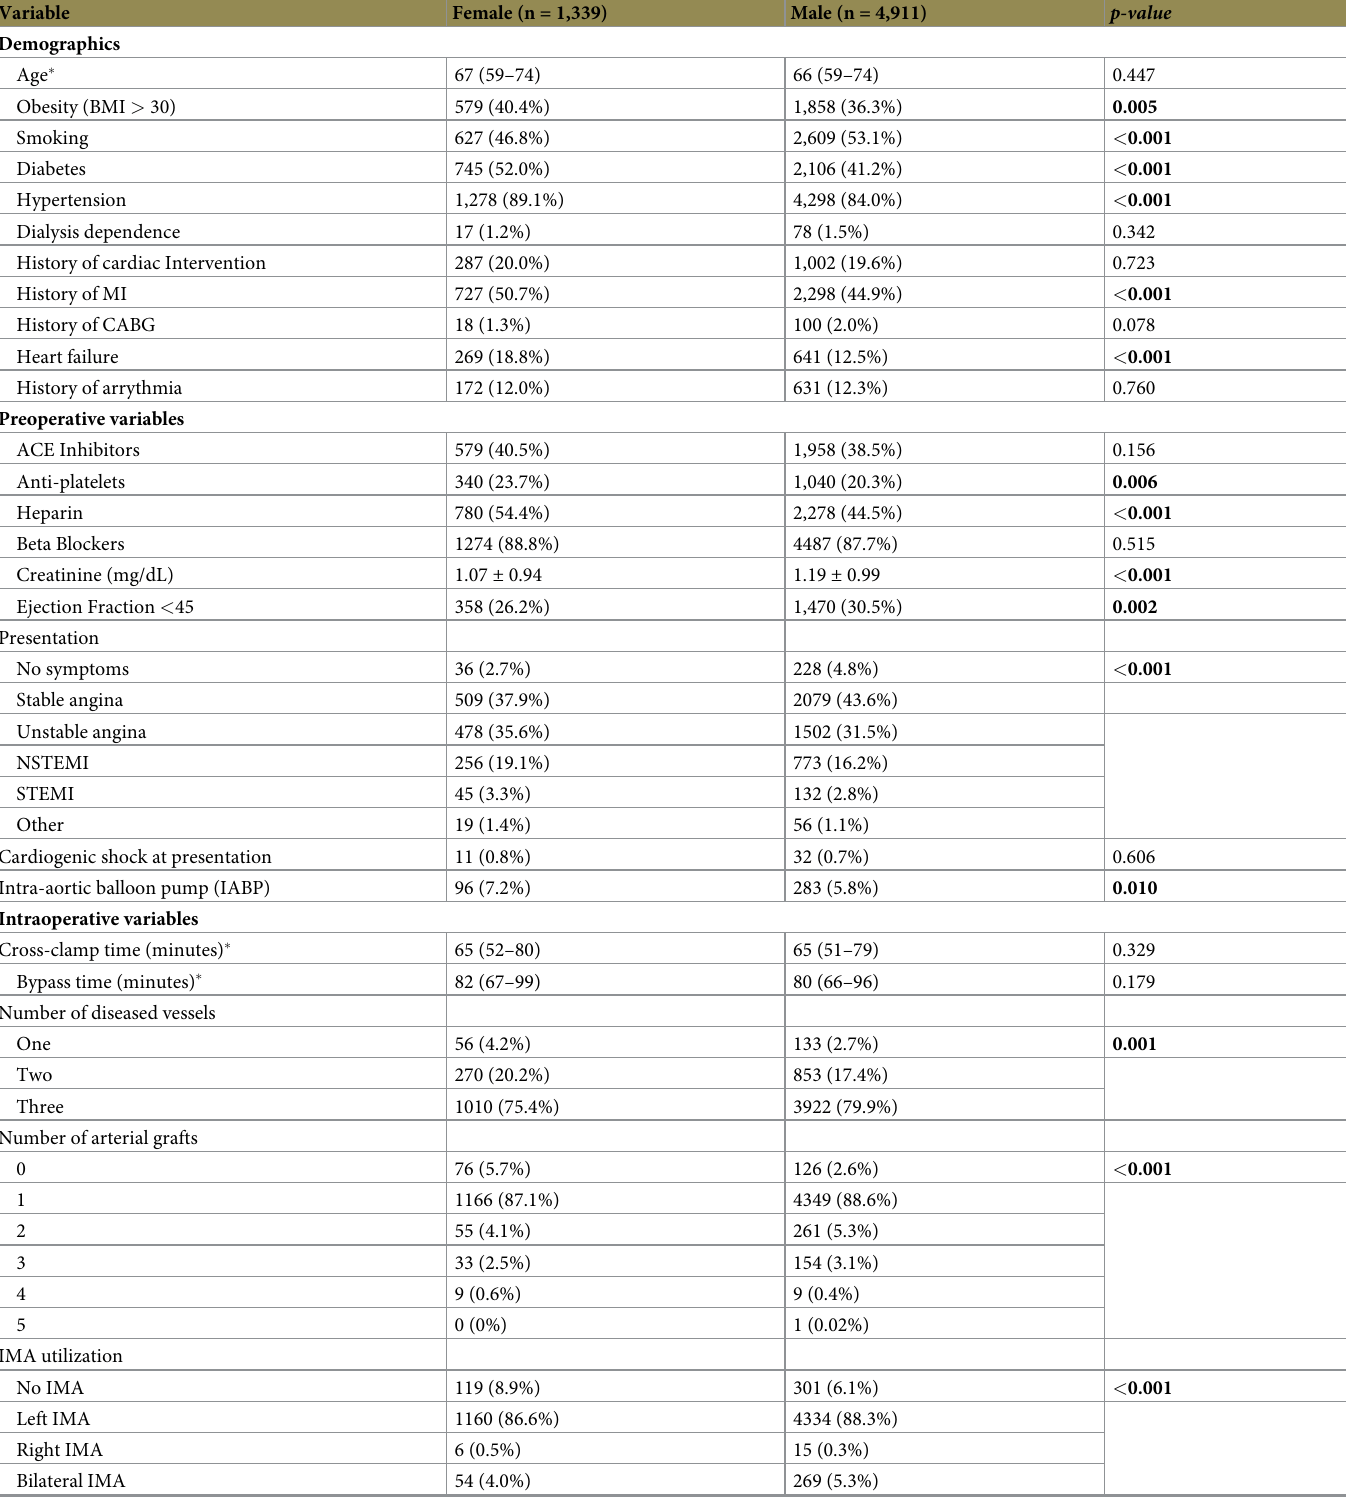
Table 1. Patient demographics and clinical characteristics stratified by